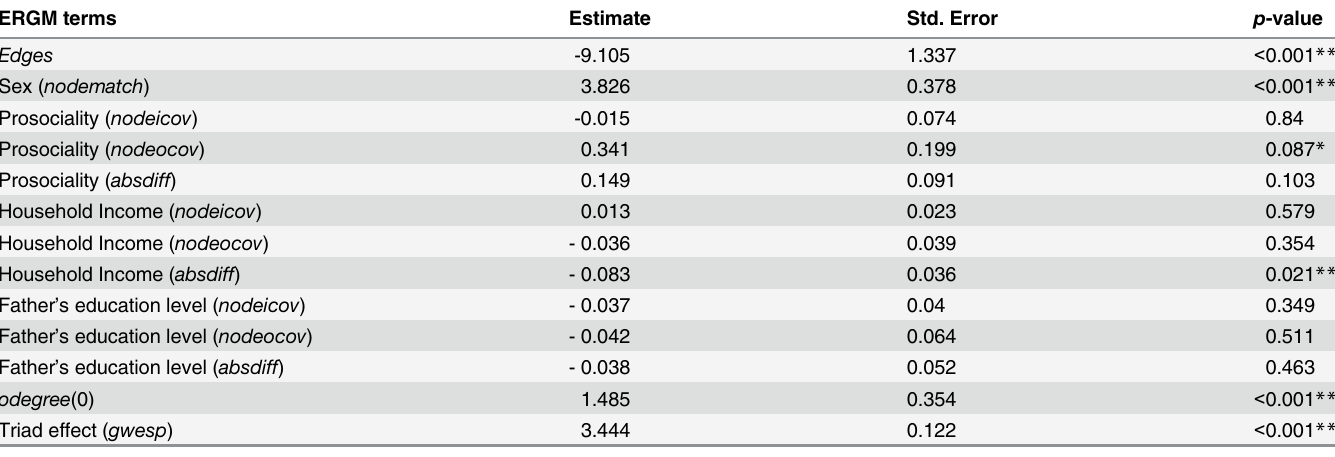
Table 7. ERGM estimates (model